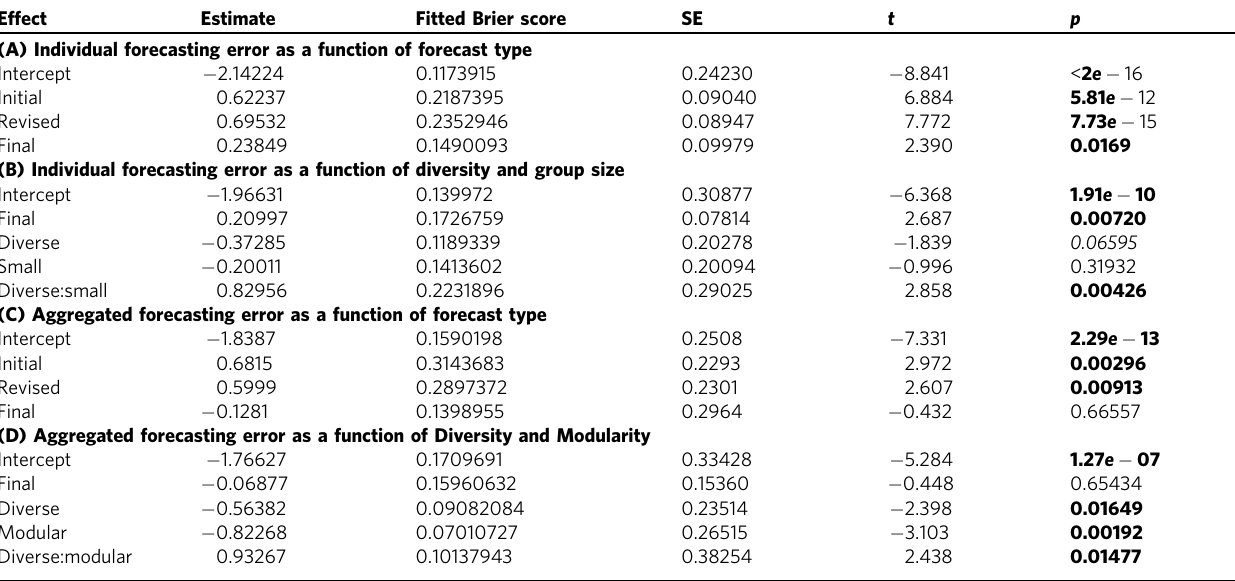
Table 1 Generalized mixed-effects models on individual and aggregated errors.